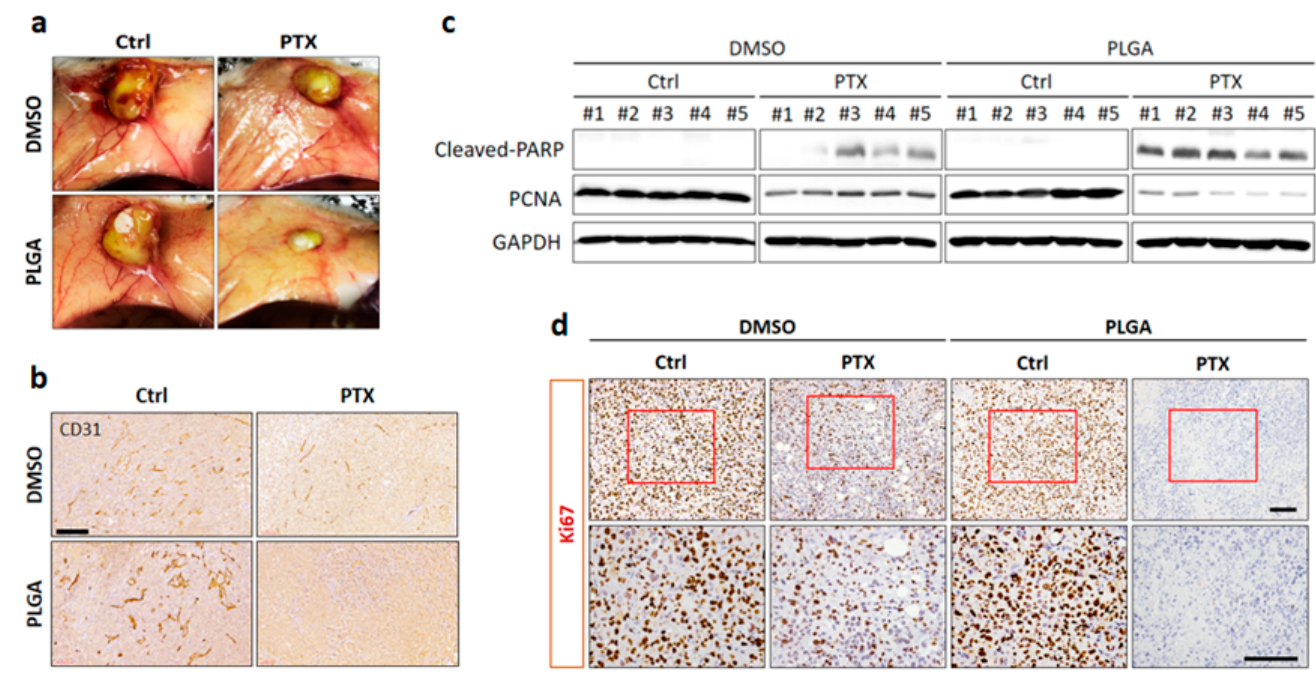
Figure 8. Effect of PTX-loaded PLGA nanofibrous membranes on tumor angiogenesis, cancer cell apoptosis, and proliferation in a breast cancer orthotopic mouse model. ( a ) Tumor size and vascular profile were evaluated by macroscopic observation. ( b ) IHC for CD31 in each treatment group of tumor sections (magnification, 20 × ). Scale bar, 200 µ m. ( c ) Representative western blots for cleaved-PARP and PCNA detection. GAPDH was used as control for equal protein loading. ( d ) IHC analysis of sections from each treatment group of tumor samples for Ki67 (upper panel, magnification, 20 × ). Red boxes indicate the enlarged area (lower panel, magnification, 40 × ). Scale bar, 100 µ m.